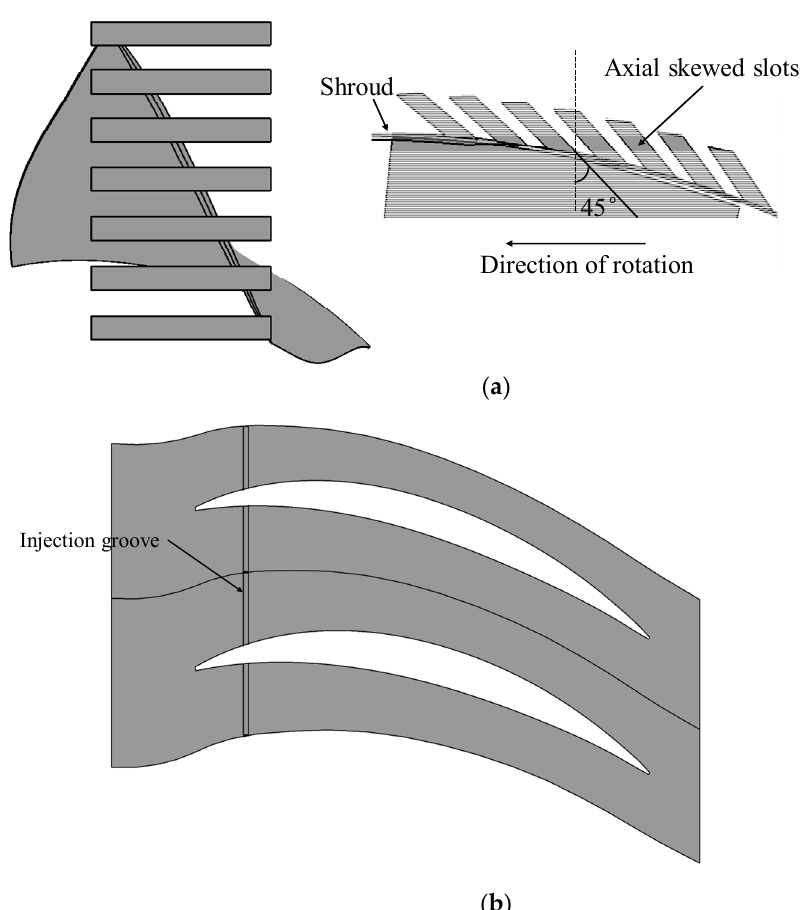
Figure 2. Geometry of ( a ) axial skewed slots and ( b ) injection groove.